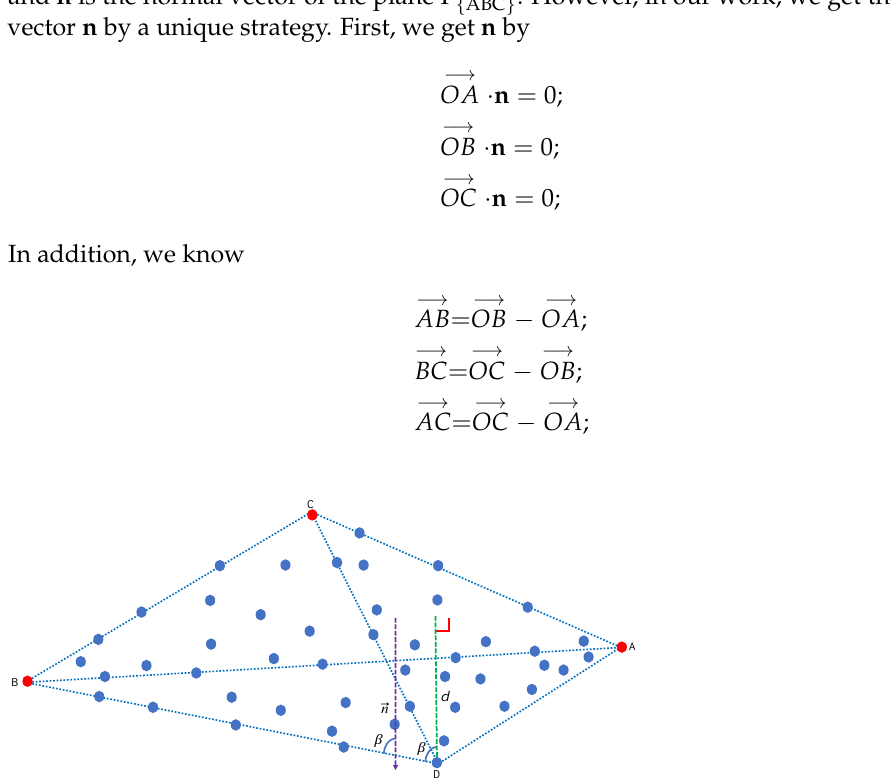
Figure 2. Schematic diagram illustrating how to extract an endmember (from three previously available ones) by using our maximum distance analysis (MDA) method. The farthest pixel point from the plane P { ABC } is the fourth